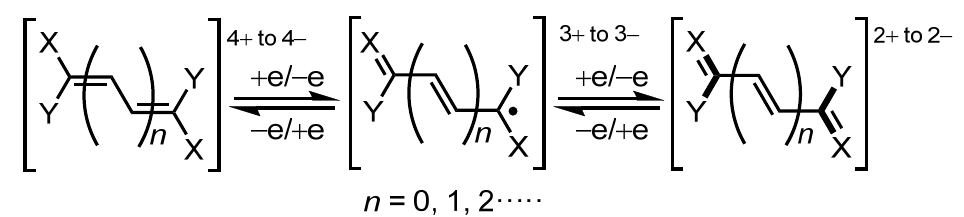
Figure 8. The general structure of violene–cyanine hybrids proposed by Hünig et al.; cyanine-type substructures produced by two-electron transfer are illustrated by bold